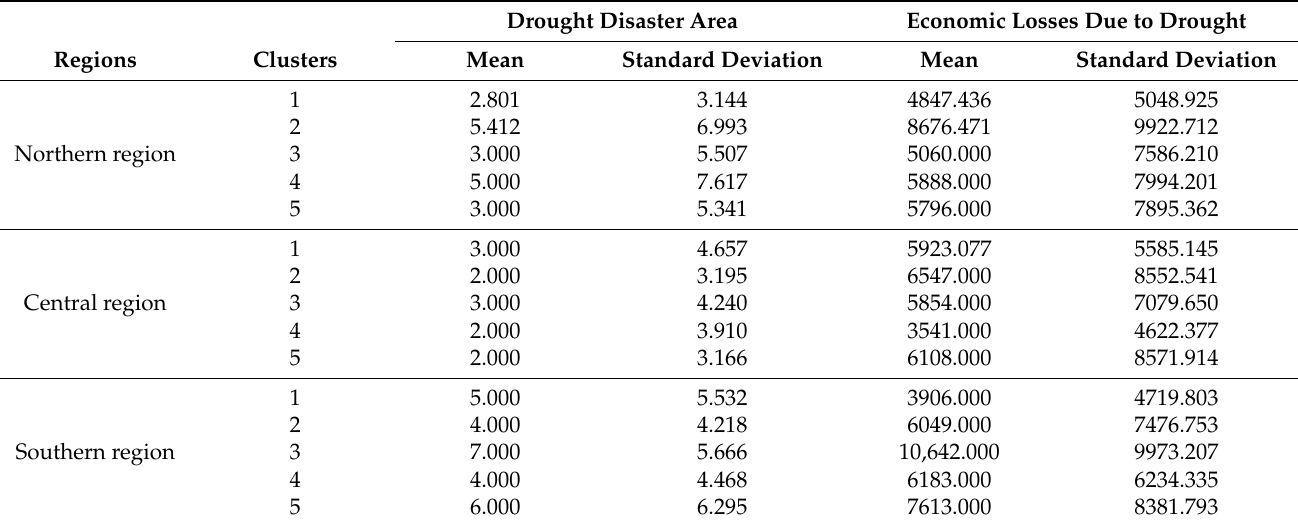
Table 5. Result of the impacts of drought on disaster area and economic loss.